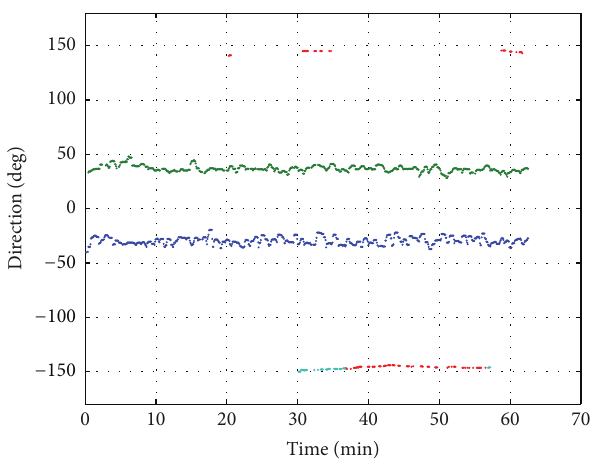
Figure 14: Visualisation of continuous audio speech tracking for a subsession of 1h 02 min (Dataset 1) performed using long- term spatial power density algorithm. The tracks are assigned to 2 different participants between − 50 ∘ and 50 ∘ . Additional track at around 180 ∘ corresponds to the remaining artefacts from remote echo cancellation.